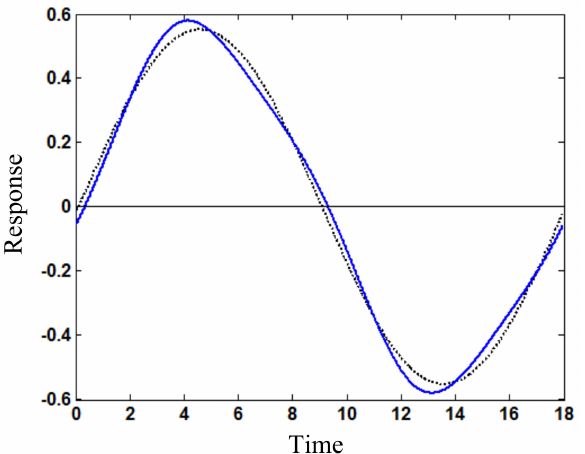
Figure 9. Stationary response ( w ) varying with time ( t ) for loading frequency ω = 0.35 (blue solid line: response based on periodic solution; black dotted line: response based on first harmonic term).